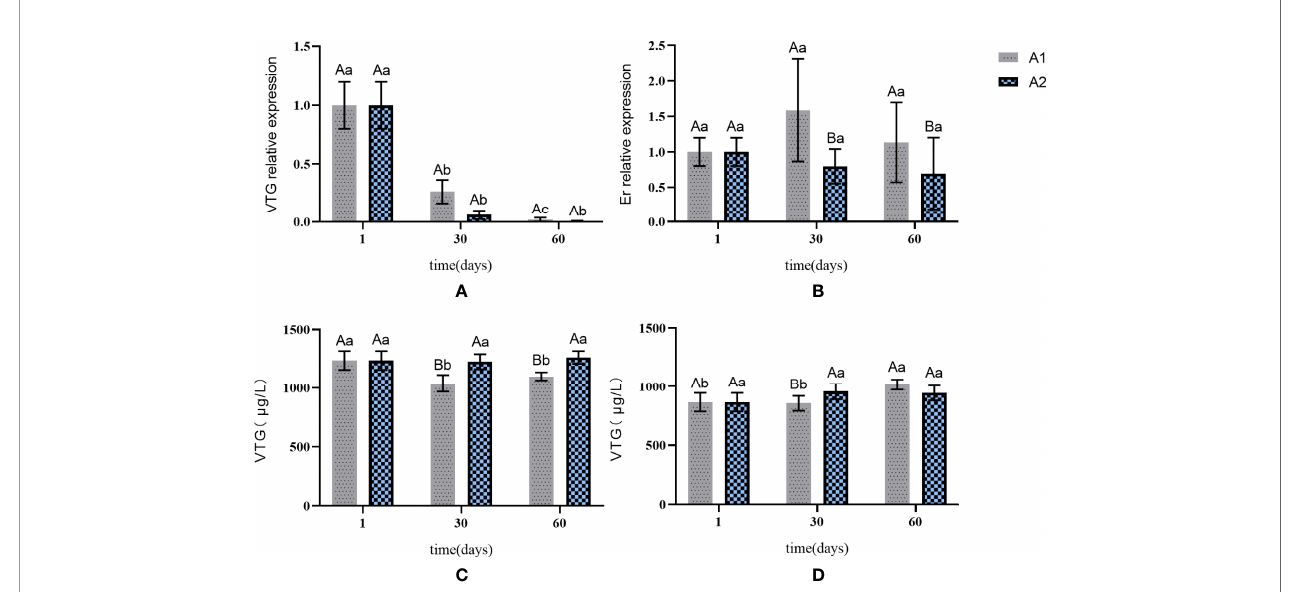
FIGURE 3 | The expression of VTG and Er genes in liver and the content of VTG in liver and serum in A1 and A2. (A) VTG gene expression in the liver. (B) Er gene expression in the liver. (C) changes in the content of VTG in the liver. (D) changes in the content of VTG in the serum. The capital letters marked in the chart indicate signi fi cant differences between the swimming group and the resting group ( p < 0.05). Lowercase letters indicate differences within the same group ( p < 0.05). VTG, vitellogenin; Er, estrogen